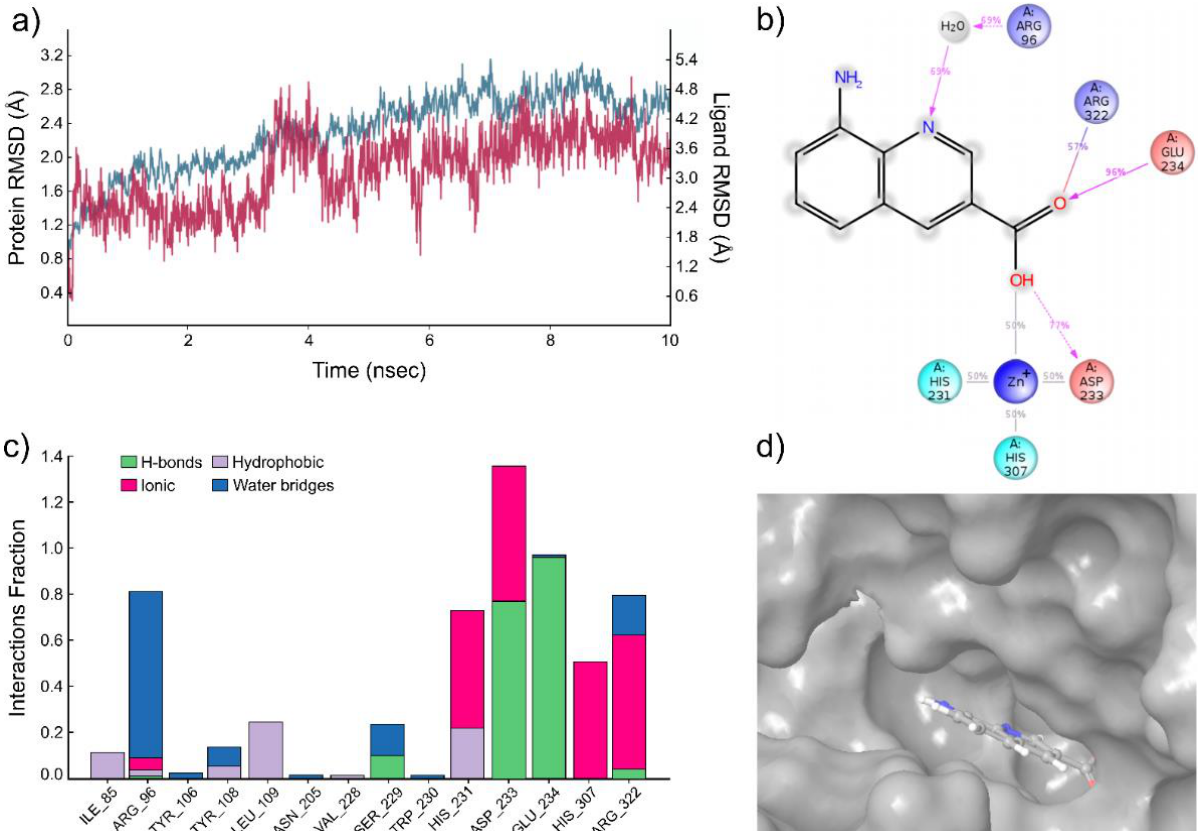
Figure 4. Results of the molecular dynamics simulation of the FTO complex with compound 3 . ( a ) The protein and ligand position root mean square deviation (RMSD) plot against time in the case of the FTO complex with compound 3 for a representative 10 ns run. ( b ) Desmond 2D profile data for the compound 3 binding to FTO protein. ( c ) Normalized stacked bar chart representation of interactions and contacts over the course of trajectory (values over 1.0 are possible as some residues make multiple contacts of same subtype with ligands); interactions occurring more than 50% of the simulation time. Interaction diagram between the compound 3 and FTO protein. ( d ) The position of the compound 3 in the structure of FTO, related to Figure 1b.